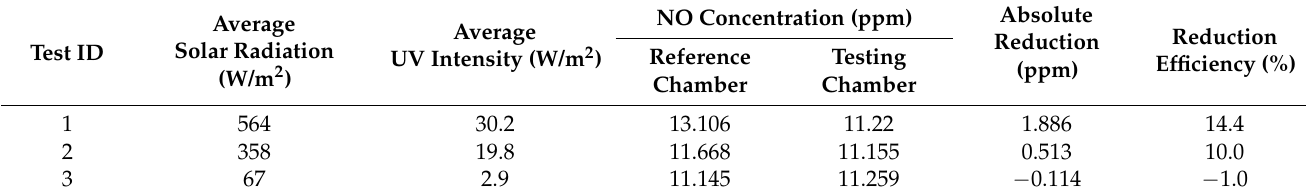
Table 7 presented the measured SO 2 reduction efficiencies for the concrete block that was treated with TiO 2 . It was found that the use of TiO 2 photocatalyst materials had an SO 2 reduction of 14.4% at 564 W/m 2 of average solar radiation. Table 7. Summary of SO 2 Absolute Reduction and Reduction